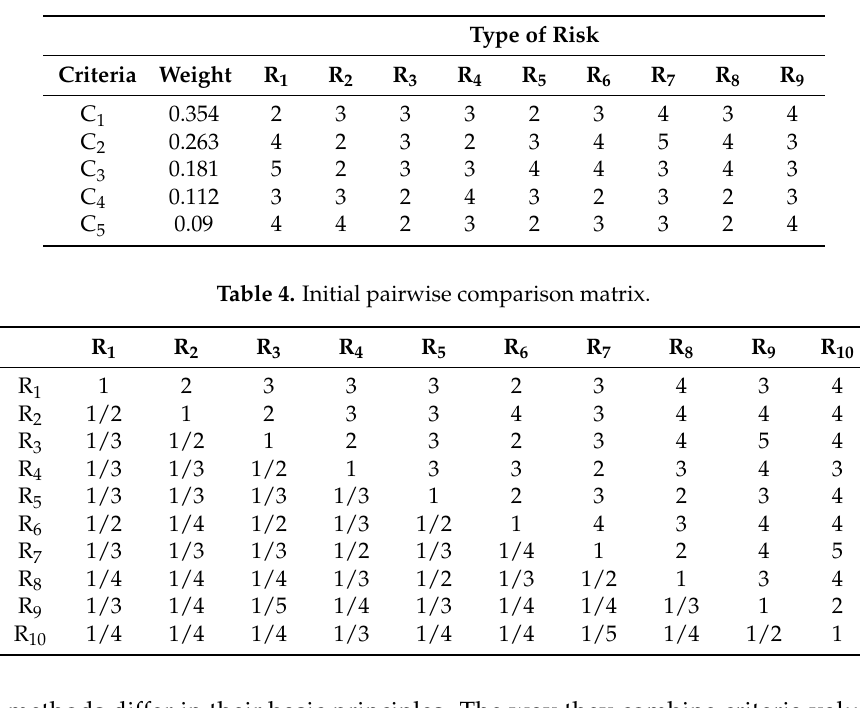
Table 3. Initial decision-making.